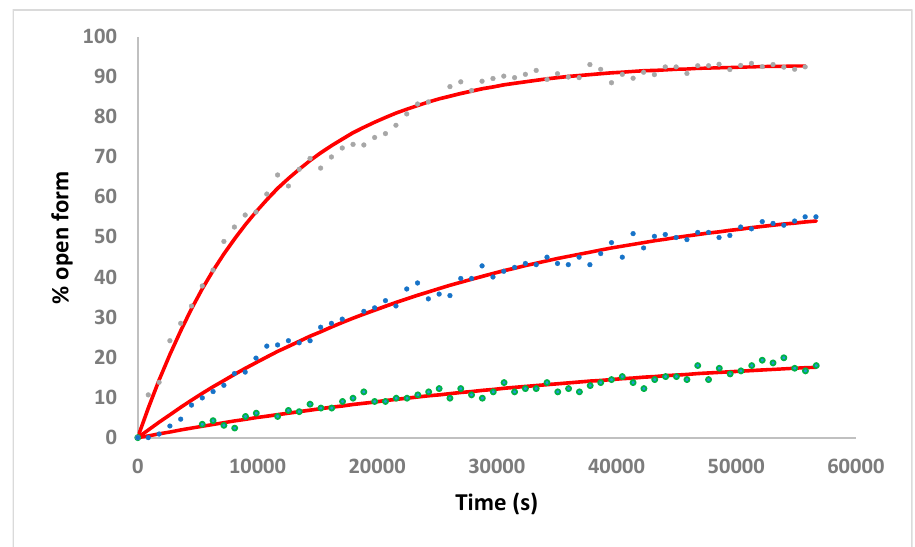
Figure 9. Time dependence of the conversion of the chelate form of 4 to the open form. pD 4.12 (grey circles), pD 4.91 (blue circles) and pD 5.96 (green circles) (2.46 mM complex, citrate / phosphate bu ff er, 310 K, 0.1 M NaCl). The solid red lines represent the fit of the equation y = C + A(1 − e − kx ) (C-o ff set from zero; A-amplitude of the curve) to each set of experimental